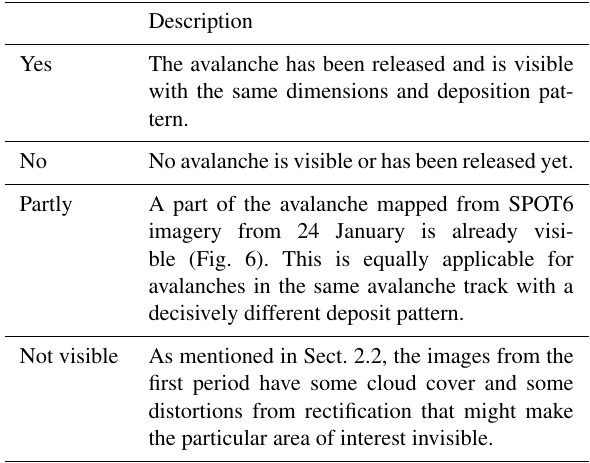
Table 3. Avalanche classification according to